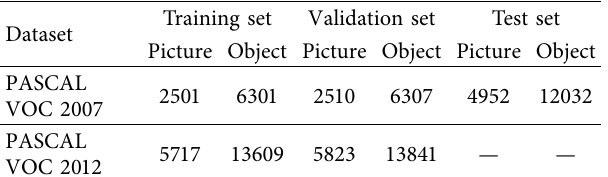
Table 2: Dataset details.